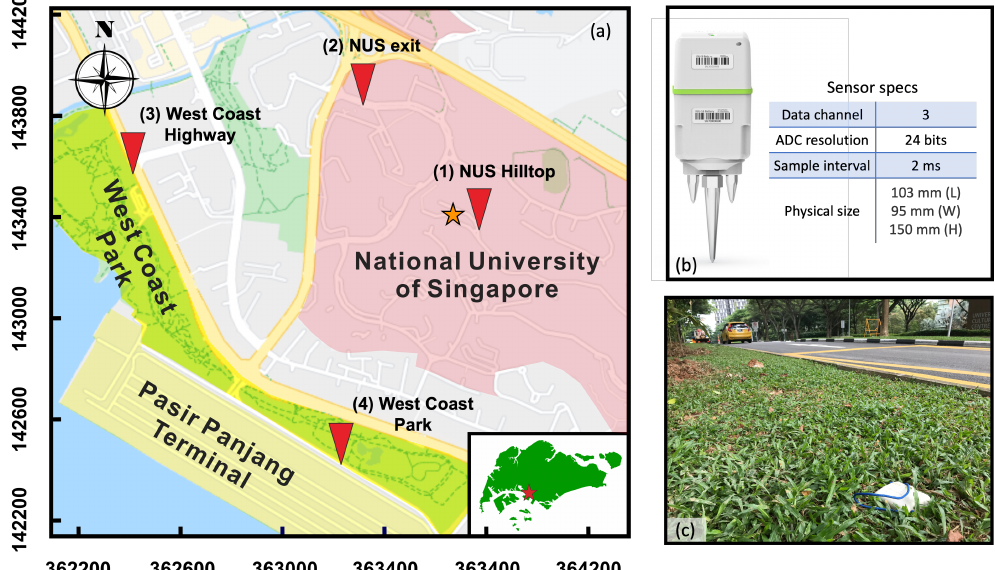
Figure 1. ( a ) Map of the nodal seismometer array deployed across the study area. The triangles denote the locations of the nodal seismometers and the star denotes the location of the weather station. The sites are named (1) NUS hilltop, (2) NUS exit, (3) West Coast Highway, and (4) West Coast Park, respectively. All four sensors are placed within a one-kilometer radius. ( b ) Picture of the Smart Solo IGU-16 3C nodal seismometer and specs of the sensor. ( c ) A picture of the sensor deployment in the turf grass by the